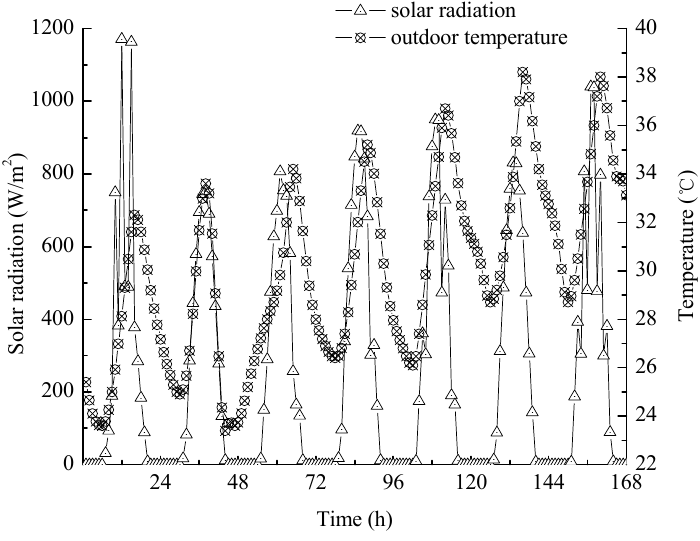
Figure 3. Solar radiation and outdoor temperature in Changsha.